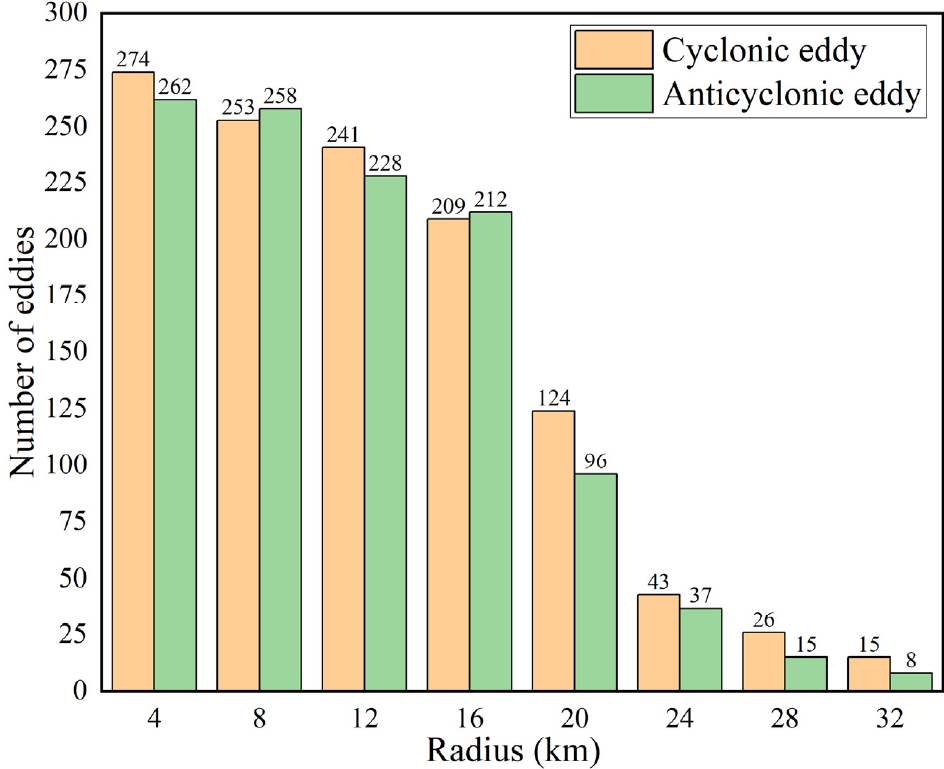
Figure 9. The relationship between eddy radius and eddy number.